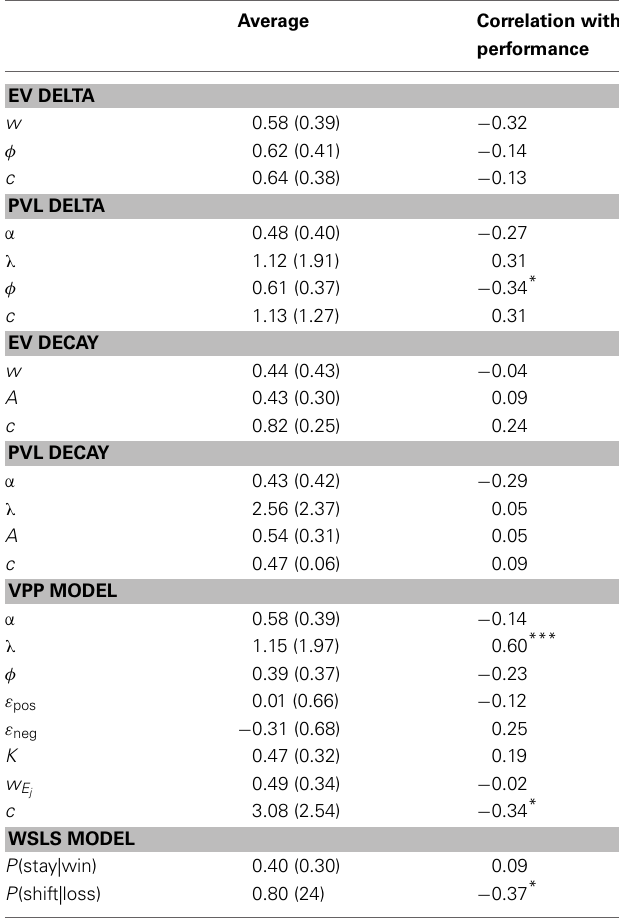
Table 3 | Average parameter estimates from maximum likelihood fits and association with performance for each